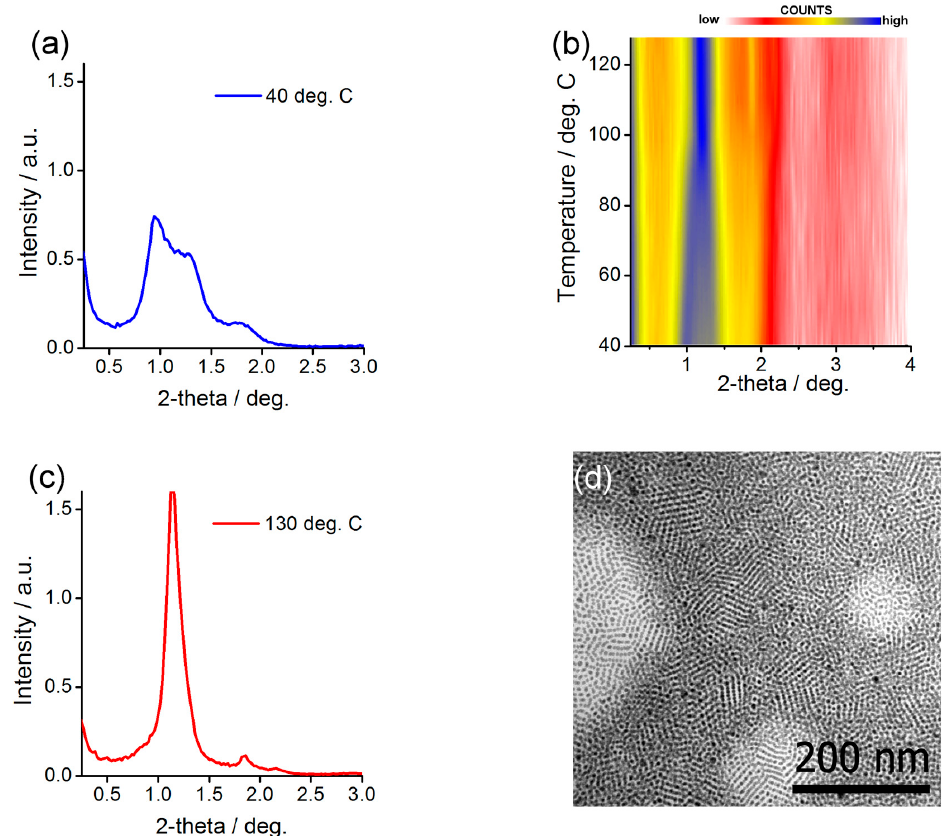
Figure 3. Structural investigation of Ag@L1/C12 nanoparticles. ( a , c ) Small angle X-ray diffraction (SAXRD) profiles for low and high temperature structures (panels a, c, respectively) ( b ) Temperature evolution of SAXRD patterns taken for annealed sample and ( d ) corresponding TEM image.